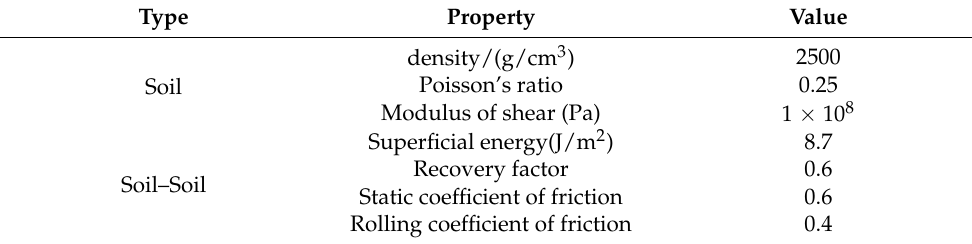
Table 2. Discrete element